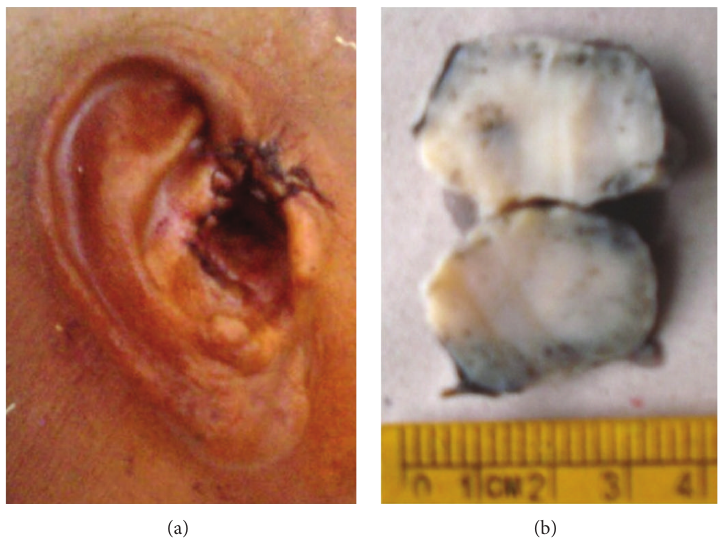
Figure 3: (a) The postoperative photograph shows that the tragus has been repositioned in its original position after excising the tumor. Sutured area in the same image shows the mass attached to the outer part of the right external auditory canal. (b) Photograph of the excised mass showing grey-white and grey-brown area in its cross